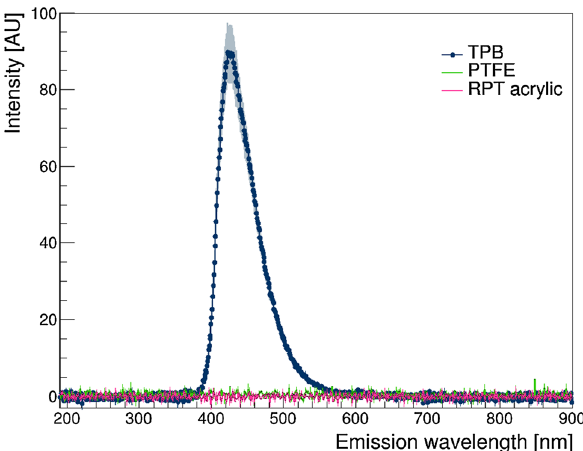
Fig. 6 Emission spectrum of TPB and no signal above noise from PTFE and RPT acrylic. All the samples were measured with 160nm excitation light at an incident angle of 39.5 ◦ . The error bars are